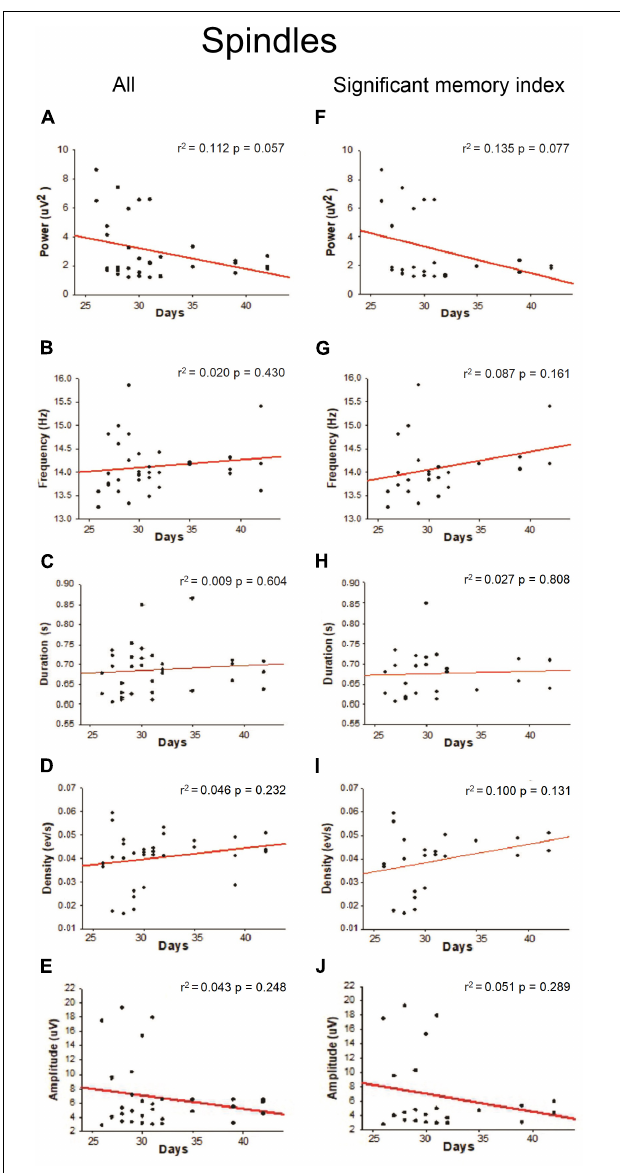
FIGURE 6 | Linear regression between SWR oscillation features with respect to postnatal days. For each postnatal day, the power (A,F) , frequency (B,G) , duration (C,H) , density (D,I) , and amplitude (E,J) were computed. The correlation analysis considered "All" animals (column on the left) or those with a "significant memory index" (column on the right). The r 2 and p -value are indicated on each regression. Significant regressions ( p < 0.05) are enclosed in a